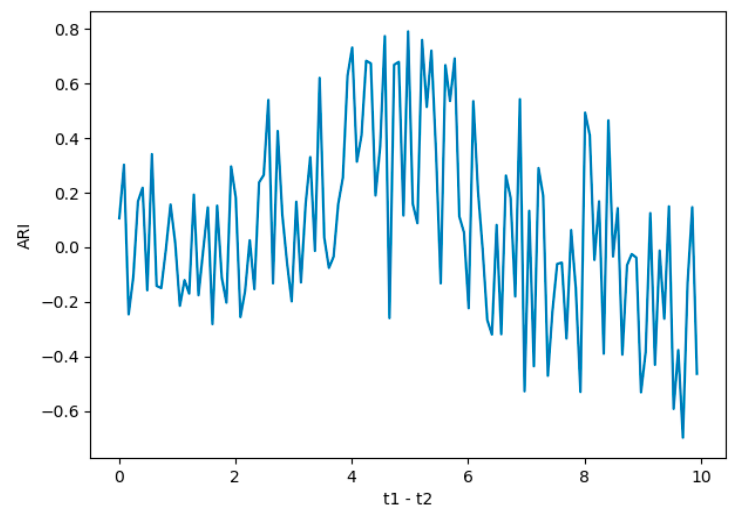
Figure 3. Parameter evaluation.